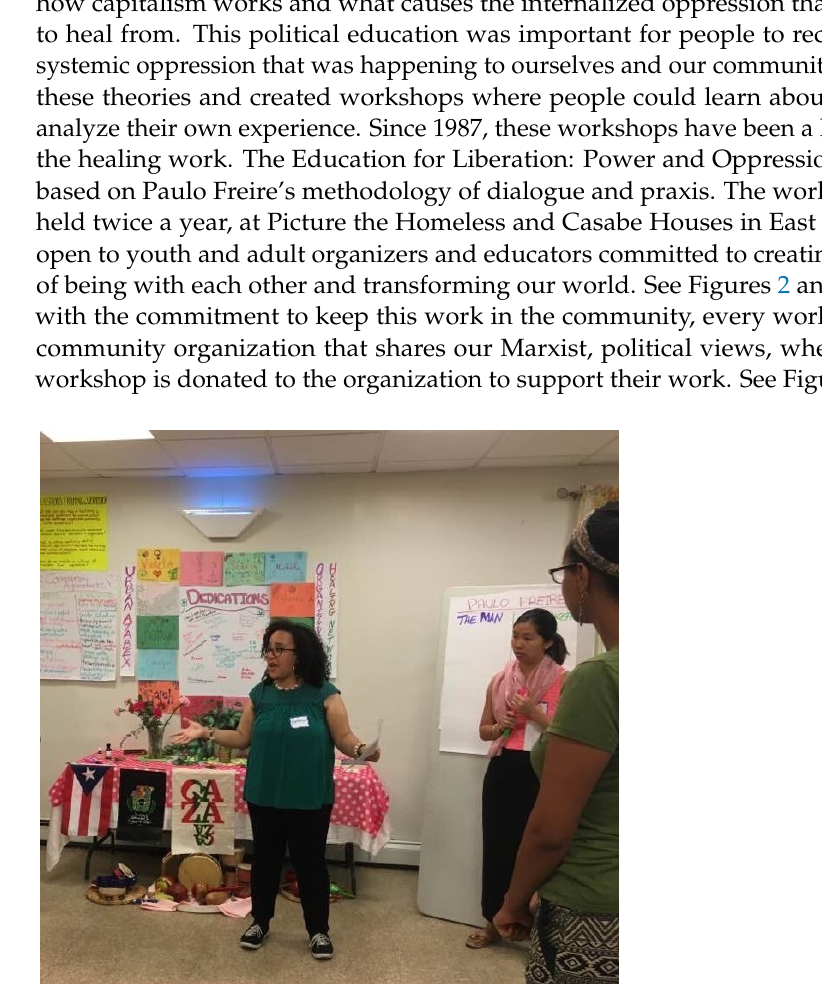
Figure 2. Facilitators at the Education for Liberation Workshop at Casabe Houses, East